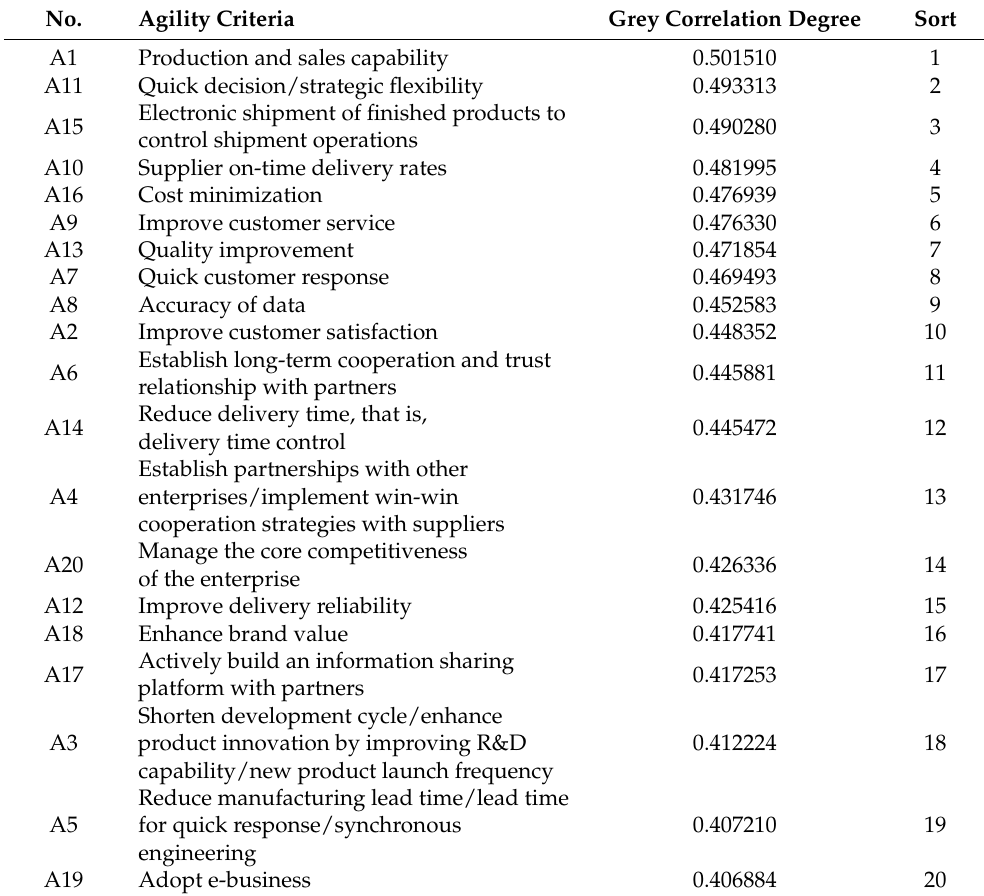
Table 18. Grey correlation degree and sorting of agility